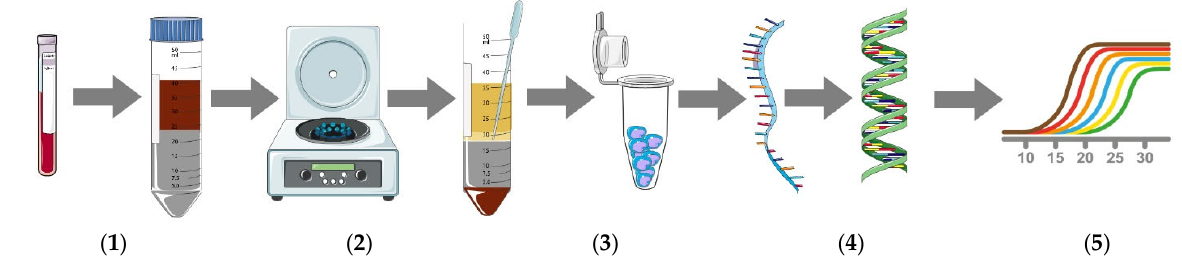
Figure 1. A schematic diagram for the study methods: ( 1 ) Blood Collection; ( 2 ) Mononuclear Cell Isolation (Ficoll–Hypaque); ( 3 ) RNA Isolation; ( 4 ) Reverse Transcription and cDNA synthesis; ( 5 ) qRT-PCR (Optimization, C T determination, and Statistical analysis). Table 1. List of specific primer sequences for all primers used in qRT-PCR. IL-12: interleukin-12, CXCL10: C-X-C motif chemokine ligand 10, CCL17: C-C motif chemokine ligand 17, CCR7: C-C motif receptor 7, ABCA1: ATP-binding cassette transporter-1, ABCG1: ATP binding cassette subfamily